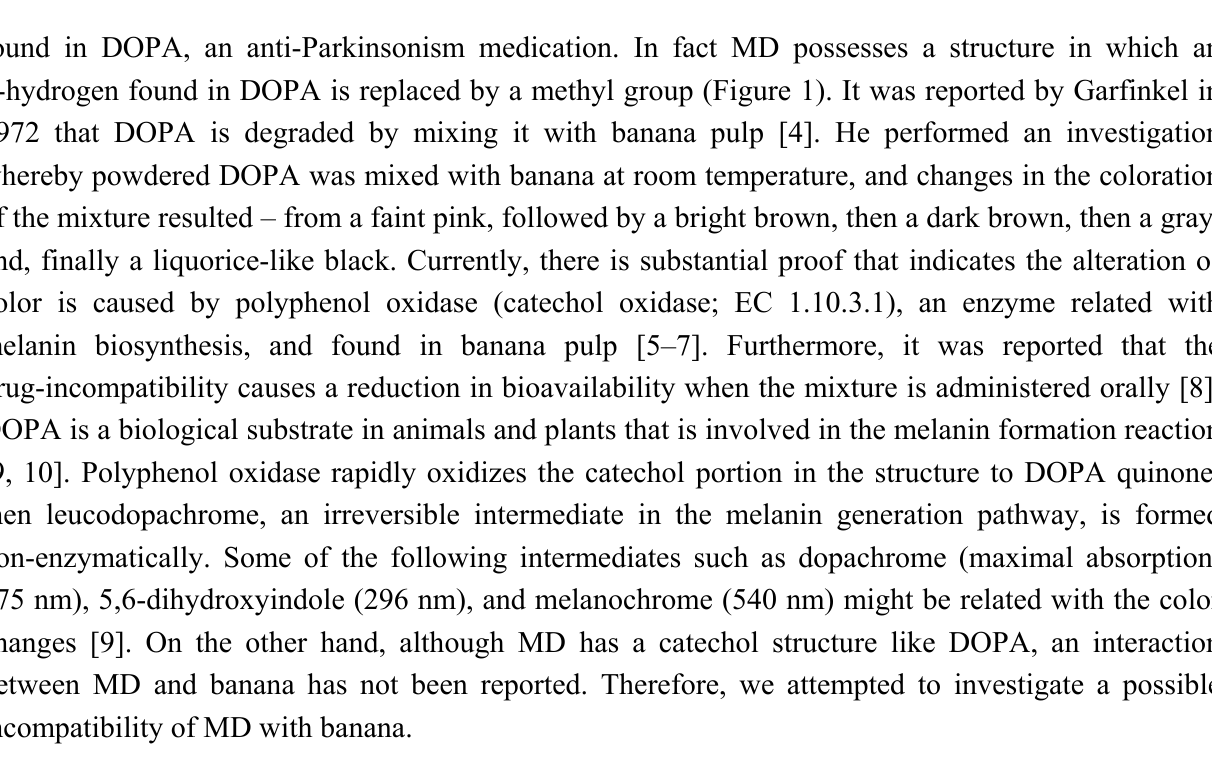
Figure 1. Chemical structures of methyldopa (left) and DOPA